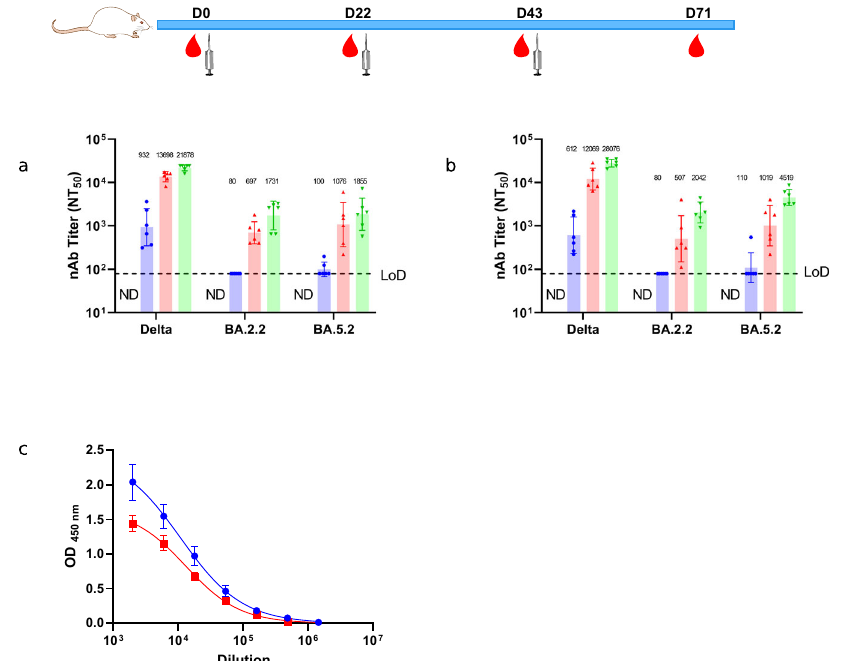
Fig. 3 Induction of neutralization antibodies by PF-D-Trimer and IgG response toward the Trimer Domain in Sprague-Dawley rats. Sprague-Dawley rats were immunized with two different doses of PF-D-Trimer formulated with alum plus CpG 1018 as indicated in the top panel and as described in “ Methods ” . Sera were collected and the neutralization activities against Delta and Omicron BA.2.2 and BA5.2 were analyzed as described in Methods. a Sera neutralization activities with 10 μ g of adjuvanted PF-D-Trimer. b Sera neutralization activities with 30 μ g of adjuvanted PF-D-Trimer. Points represent individual animal; bars indicate geometric mean titers (GMT) responses (with geometric standard deviation). Every bar in different colour represents a different time point of blood collection ● Day 22, ▲ Day 43, ▼ Day 71. Dotted lines indicate the limit of detection, LOD; 80. ND = At D0 the neutralizing antibodies were not detected. c ELISA binding curves of SD rats sera depleted with recombinant puri fi ed Monkeypox L1R-TD-Trimer to assess the removal of Trimer Domain-speci fi c antibodies. Bars indicate standard deviation. ● Non-depleted sera, ■ Depleted